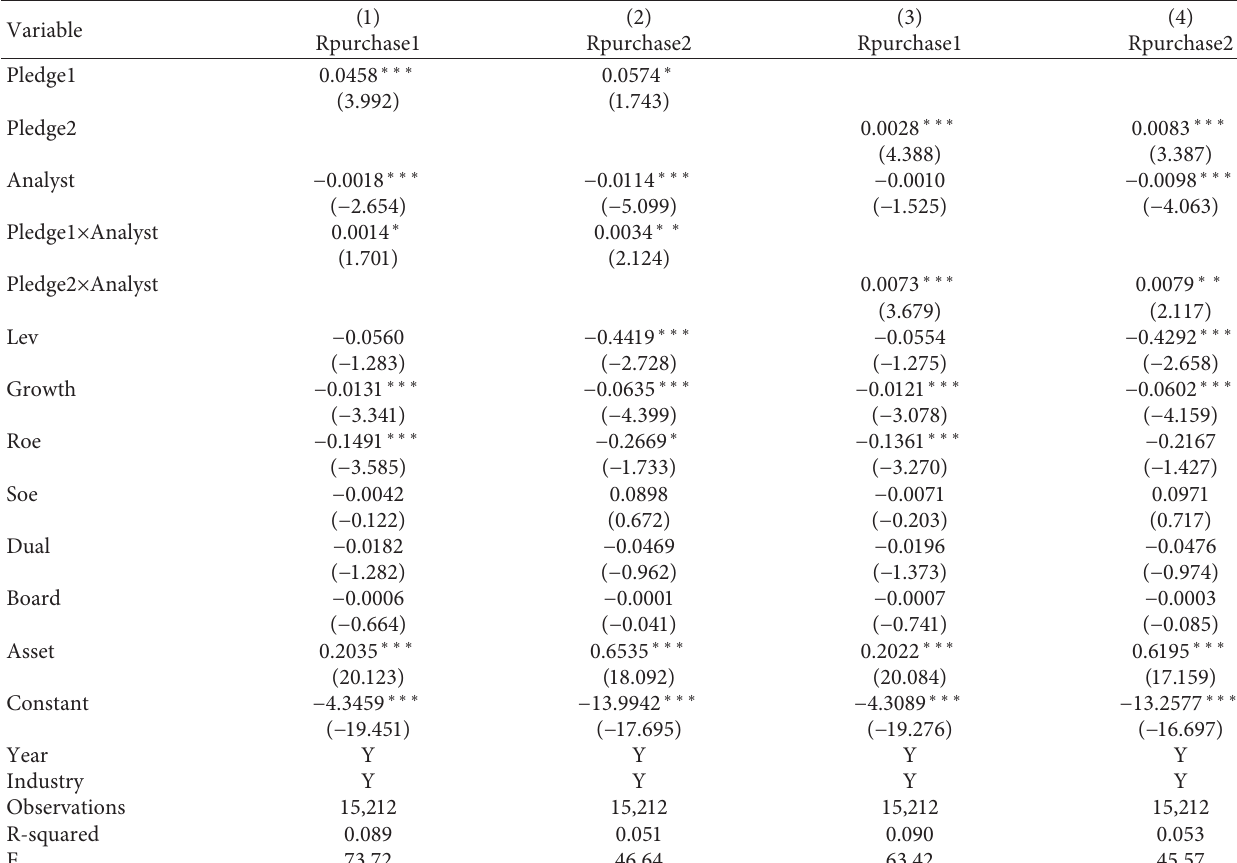
Table 9: Estimated results of controlling shareholders’ equity pledge, information environment, and listed companies’ stock repurchase. Variable